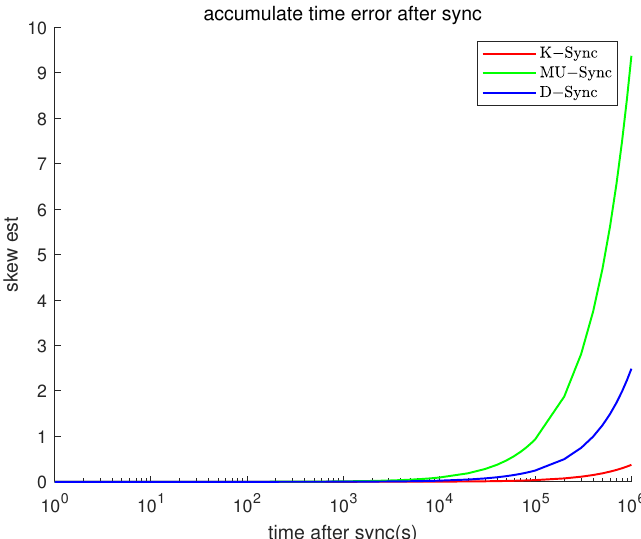
Figure 6. Clock error vs. time after sync (Model